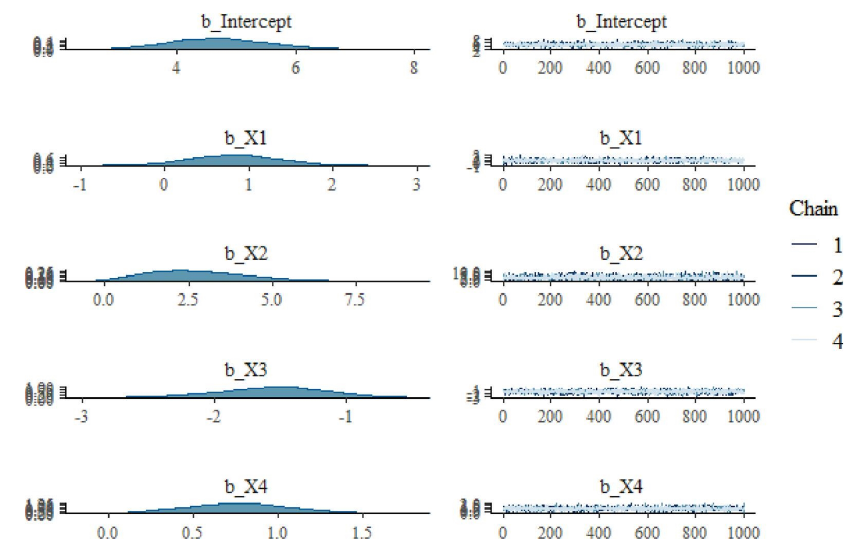
Figure 1: Graphical representation of coefcient parameters for negative or positive outcomes of prostate